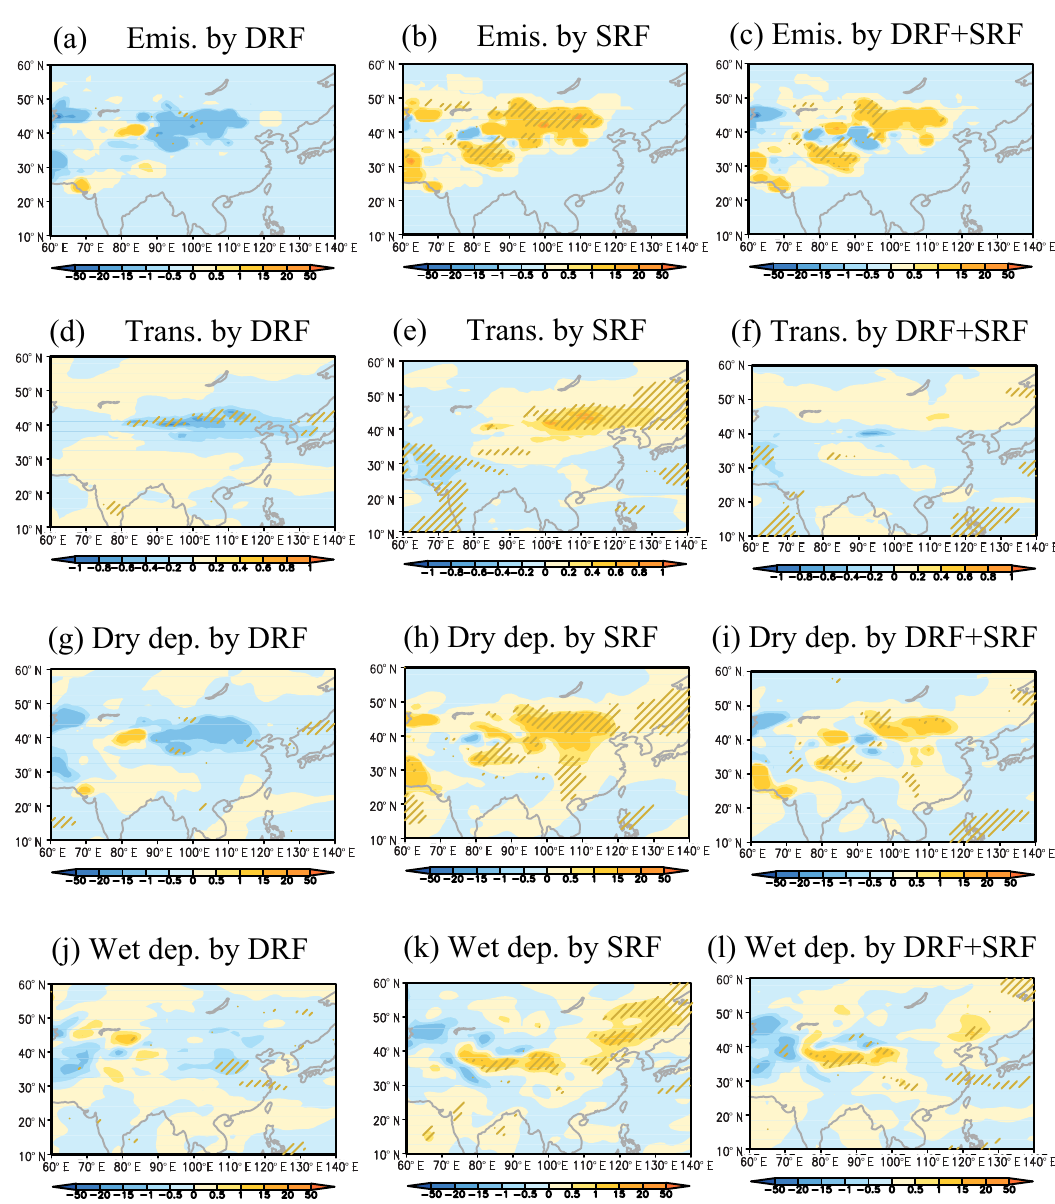
Figure 5. Dust cycle changes including (a, b, c) dust emissions (gm − 2 per season), (d, e, f) dust transport (gm − 1 s − 1 ), (g, h, i) dust dry deposition (gm − 2 per season) and (j, k, l) dust wet deposition (gm − 2 per season) in MAM induced by dust direct radiative forcing (DRF), dust-in-snow radiative forcing (SRF) and total forcing (DRF + SRF). The slanted lines represent the grid points where the changes pass the two-tailed t test at the 5% significance